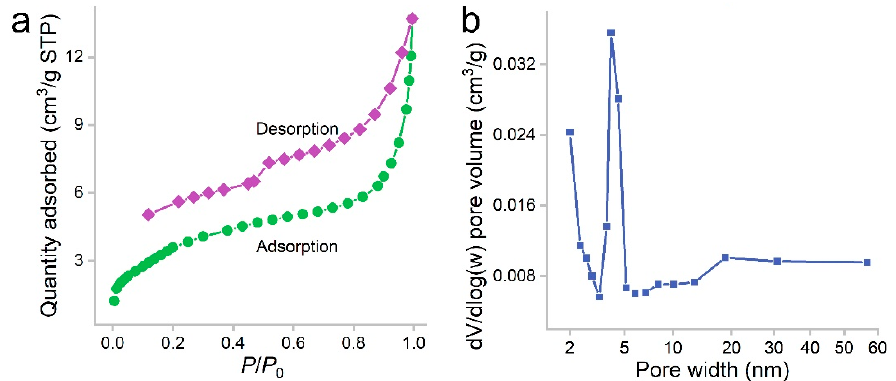
Figure 2. Nitrogen adsorption/desorption isotherms ( a ) and pore size distribution ( b ) of PCS.